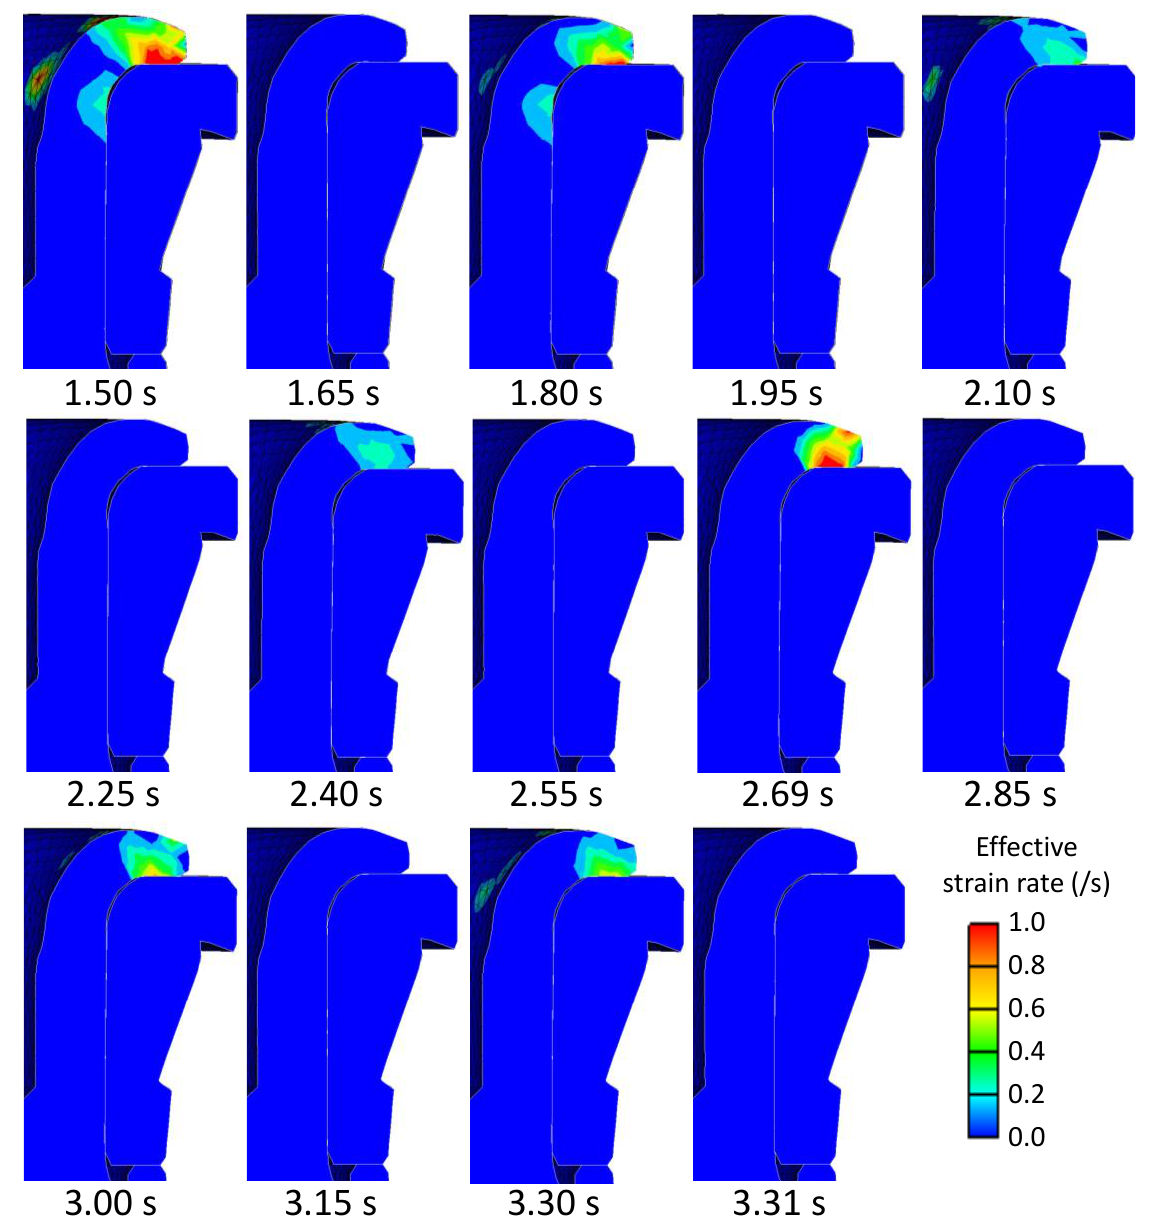
Figure 10. Bending of the extreme shaft end and safe preloading during homogenizing. After homogenizing, residual stress was evident, which was near-axisymmetric. The maximum effective stress exerted on the upper inner race (1660 MPa at commencement of homogenizing) decreased to 1210 MPa when springback occurred as the forming roller separated from the material.